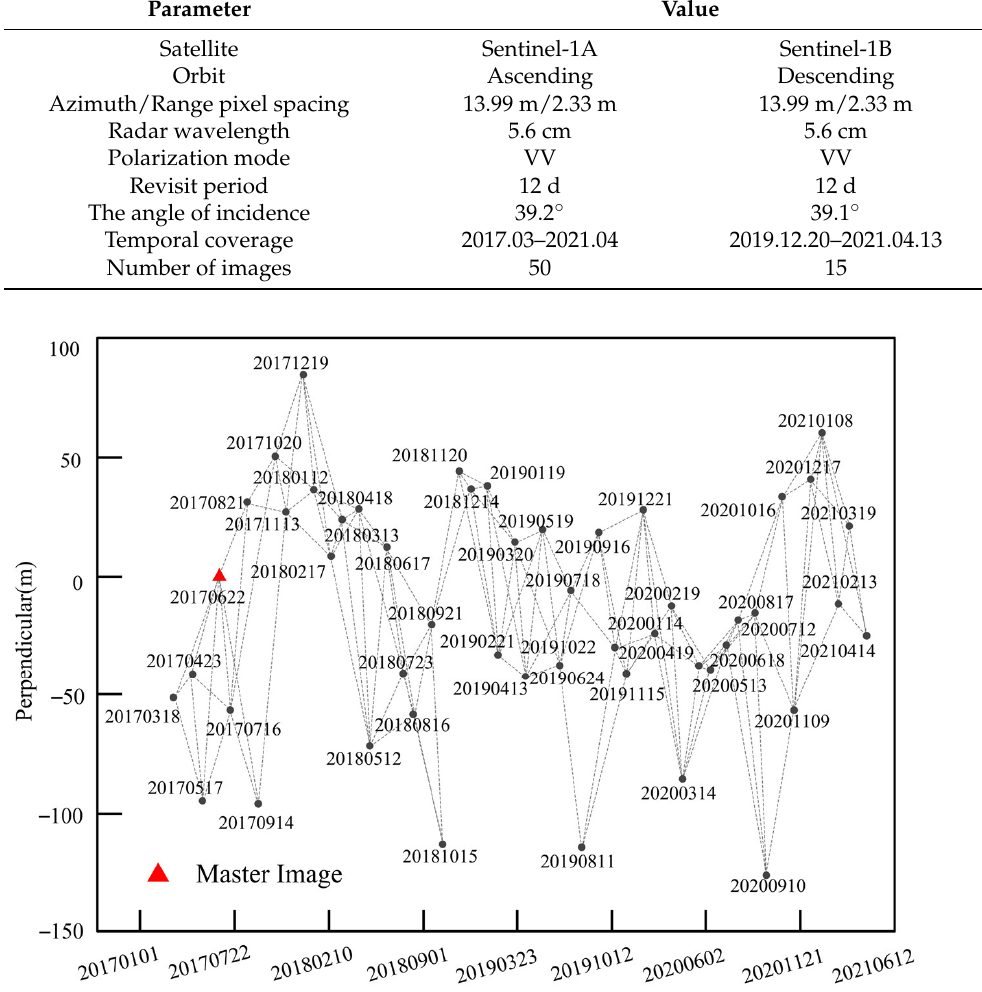
Table 1. Basic information of the Sentinel-1 images.